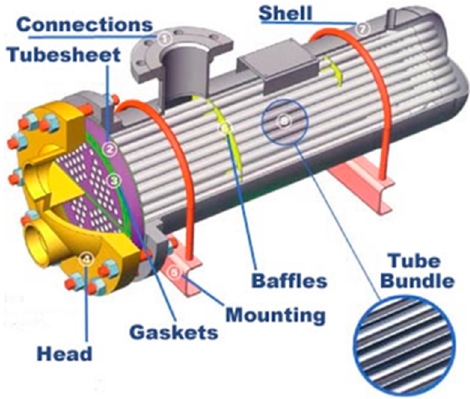
Figure 19. Shell and tube heat exchanger (source: South West Thermal Technologies Inc. http://www.SouthwestThermal.com).